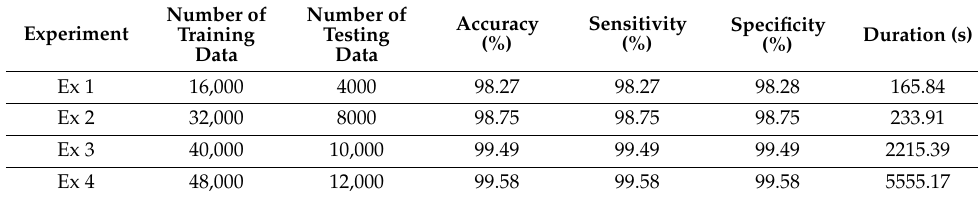
Table 6. CDELM performance based on number of data.